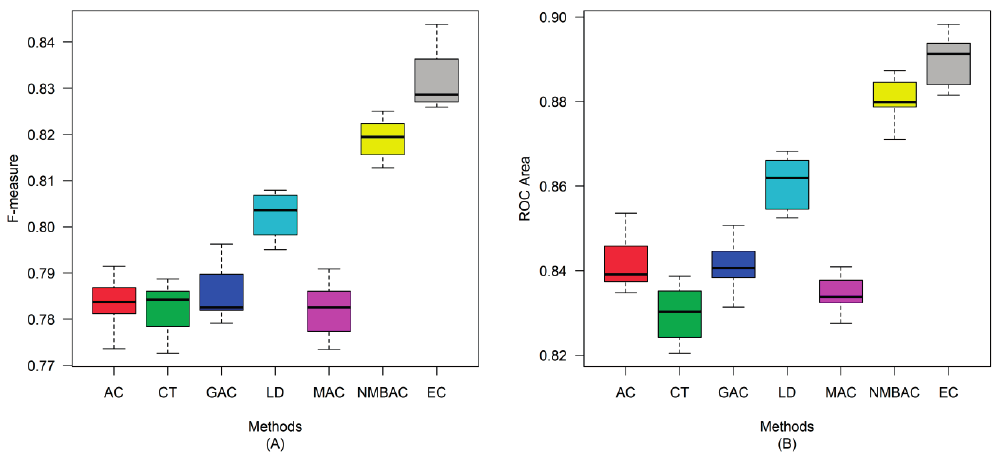
Figure 15. Average F-measure and ROC area of different methods on the Gold Human dataset with five-fold cross-validation. ( A ) F-measure; ( B ) ROC